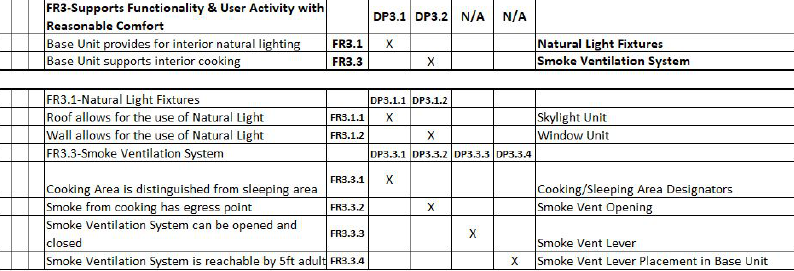
Figure 21. AD Top-Level Design Mapping of DPs for FR3.